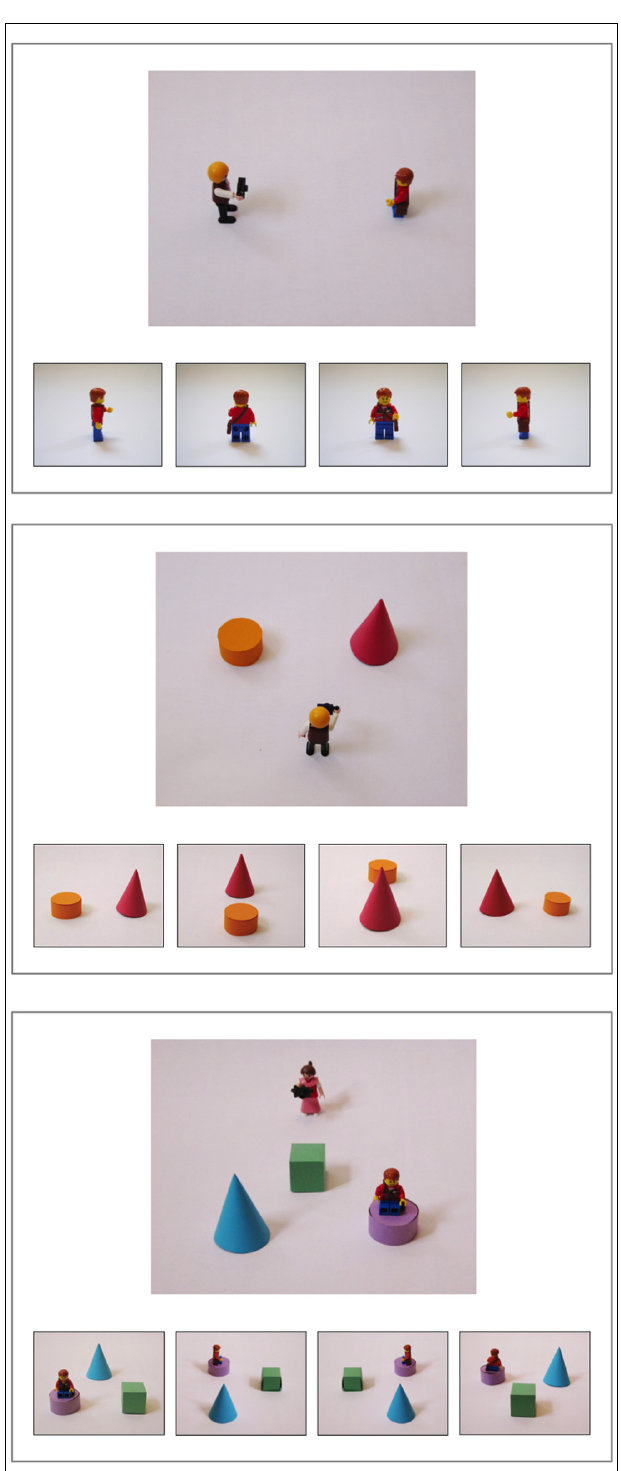
FIGURE 2 | Examples for stimuli presented in test trials, varying in spatial complexity (1, 2, or 4 objects) and perspectives (90, 0, or 180 ◦ ). Stimuli were presented exactly as shown, as color printouts on separate letter-sized sheets of paper.